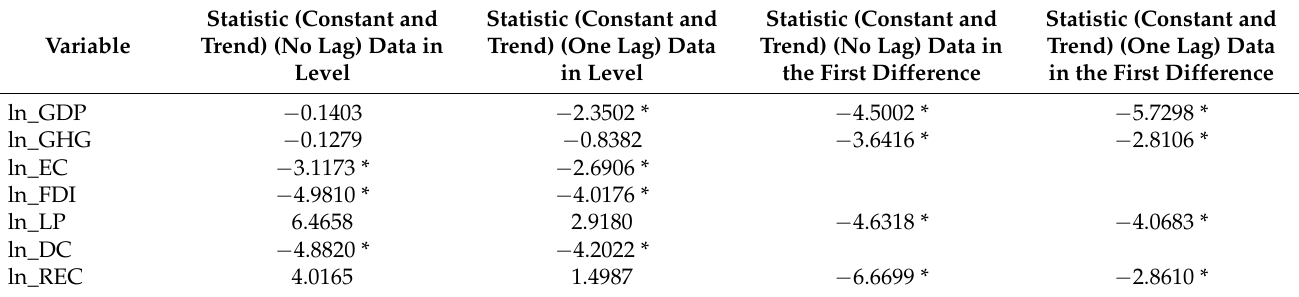
Table 3. The Breitung test—results (1996–2019) 1 .